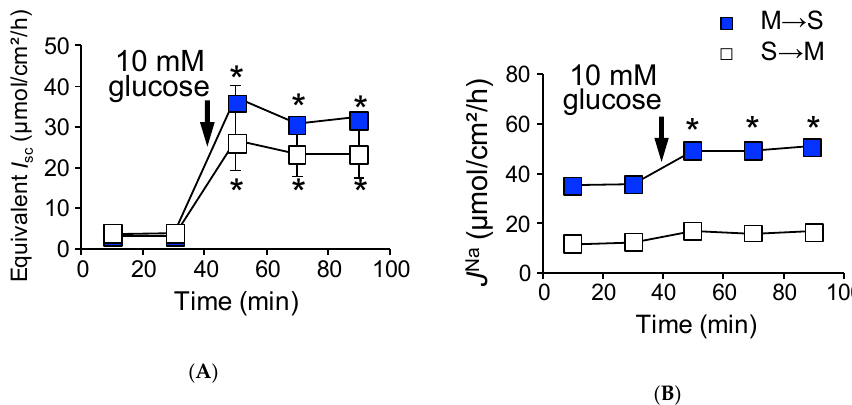
Figure 6. Robust glucose-induced J Na MS are observed in cldn15 − / − mice under open-circuit conditions: Glucose-induced equivalent I sc ( A ) and ∆ J Na ( B ) were measured simultaneously under open-circuit conditions. Where indicated by the arrows, glucose was added to the mucosal side. Equivalent I sc was determined the same as in Figure 3. Closed squares indicate J Na MS and open squares indicate J Na SM ( n = 7 and 6, M to S and S to M, respectively). Each point represents the mean ± SE. Where error bars are absent, they are smaller than the symbol used. * p < 0.05 as compared with the baseline control.